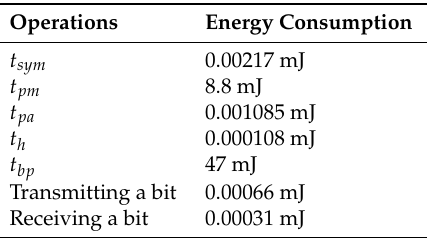
Figure 8. The total communication energy consumption in different protocols. Table 3. Energy consumption for computing and